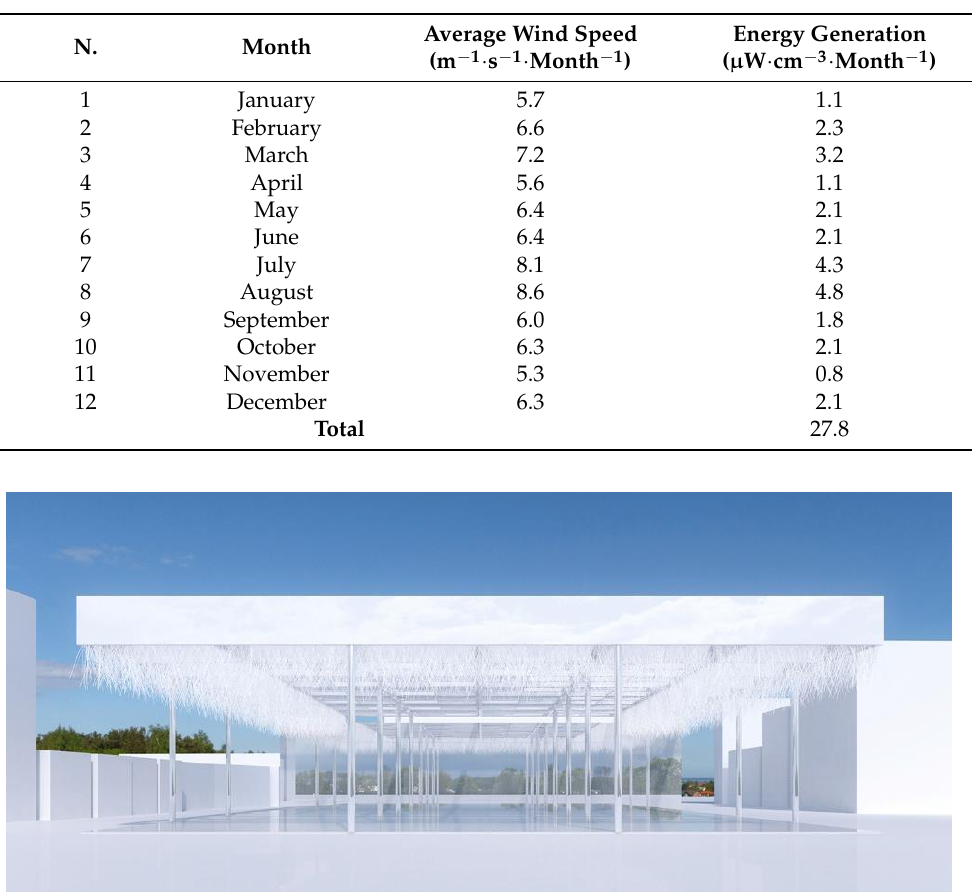
Table 5. Energy generation of a prototype (volume = 0.144 cm − 3 ) of PVDF (LDT4-028 K/L), which is (L) 60 mm × (W) 120 mm × (t) 0.2 mm, according to the monthly wind speed. N.